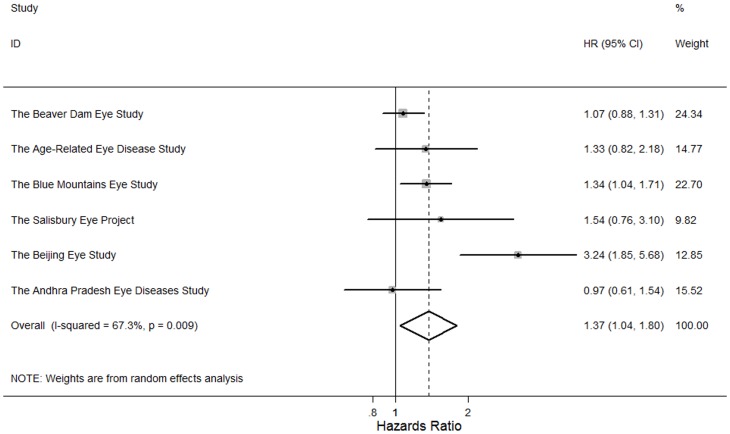
Random effects meta-analysis investigating the association between posterior subcapsular cataract and all-cause mortality.HR = hazards ratio; CI = confidence interval.